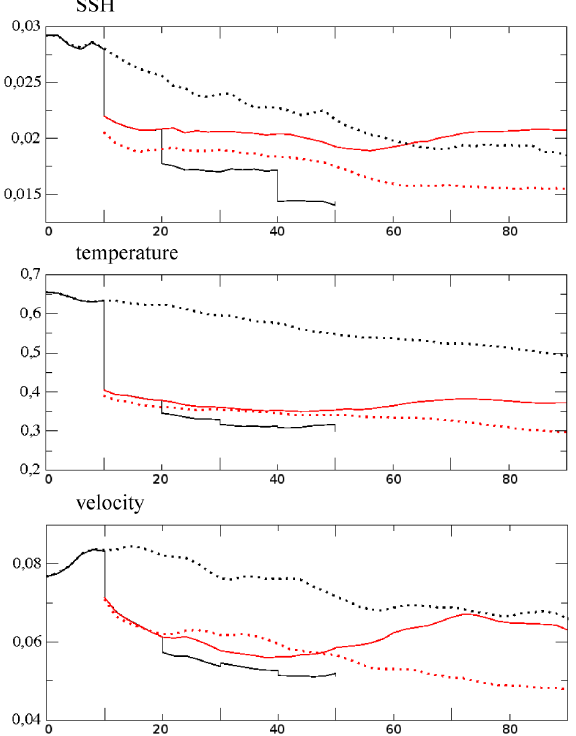
Fig. 10. RMS errors for the SSH (m), the temperature ( ◦ C) and the Fig. 11. RMS errors for the SSH (m), the temperature ( ◦ C) and zonal velocity (ms − 1 ), for the optimal interpolation (full black line) the zonal velocity (ms − 1 ), for the optimal interpolation (full black Fig. 10. RMS error for the SSH (m), the temperature ( ◦ C) and the zonal velocity (m s − 1 ), for the optimal and the smoother (red circles). Fig. 11. RMS error for the SSH (m), the temperature ( ◦ C) and the zonal velocity (m s − 1 ), for the optimal line) and the free runs restarted with the corrected state at day 10 interpolation (full black line) and the smoother (red circles). interpolation (full black line) and the free runs restarted with: the corrected state at day 10 with OI (full with OI (full red line) or the smoothed state based on OI at day 10 red line), the smoothed state based on OI at day 10 (dotted red line). The RMS error for FALSE is also (dotted red line). The RMS errors for FALSE are also indicated by indicate with the dotted black line. the dotted black